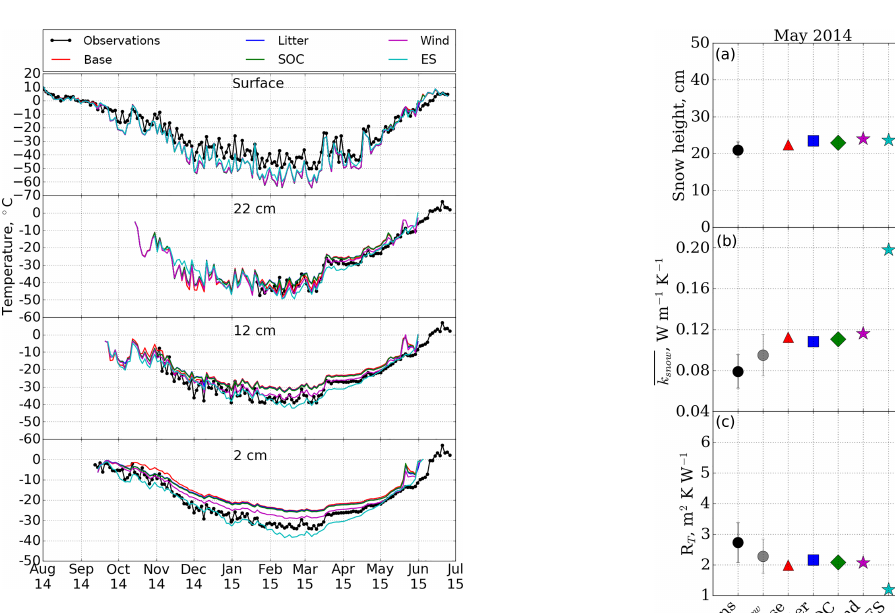
Figure 6. Evolution of simulated and observed temperatures within the snowpack during winter 2014–2015. Observations at 2, 12 and 22cm come from the NPs, and the surface temperature is measured by the IR120 sensor.